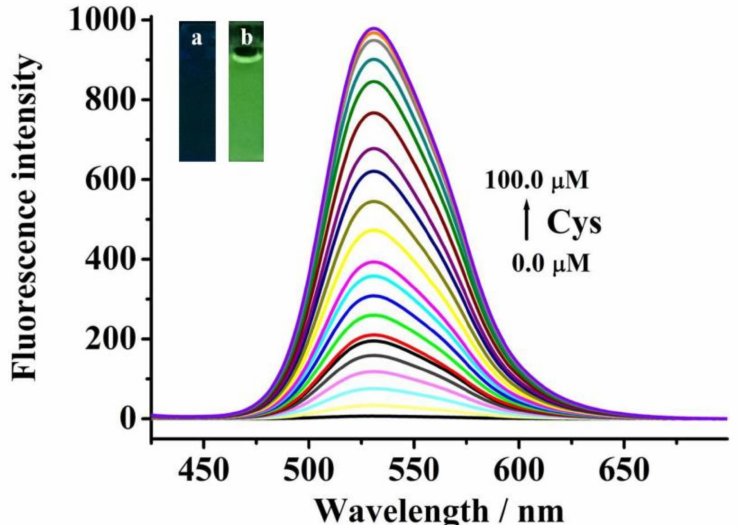
Figure 2. Fluorescence spectra of probe 1 (5.0 µ M) upon the addition of Cys (0.0~100.0 µ M) in the solution containing PBS buffer (pH = 7.4, 50.0 mM) and 20% of DMSO ( λ exc = 413 nm) ( λ exc = 413 nm, and t = 15 min). Inset: the corresponding fluorescence images of probe 1 (5.0 µ M) in the absence (left) and presences (right) of Cys (100.0 µ M) under a 365 nm UV